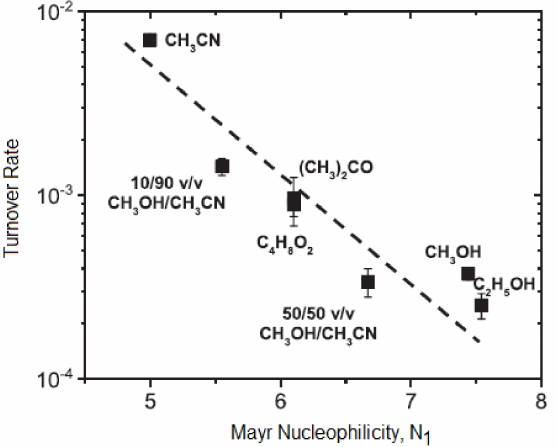
Figure 12. Turnover rates (mol C 6 H 8 SO)(mol M · s) -1 for the oxidation of C 6 H 8 S as a function of solvent nucleophilicity over Ti-Beta. Adapted from ref. [47], used with permission. Copyright 2018